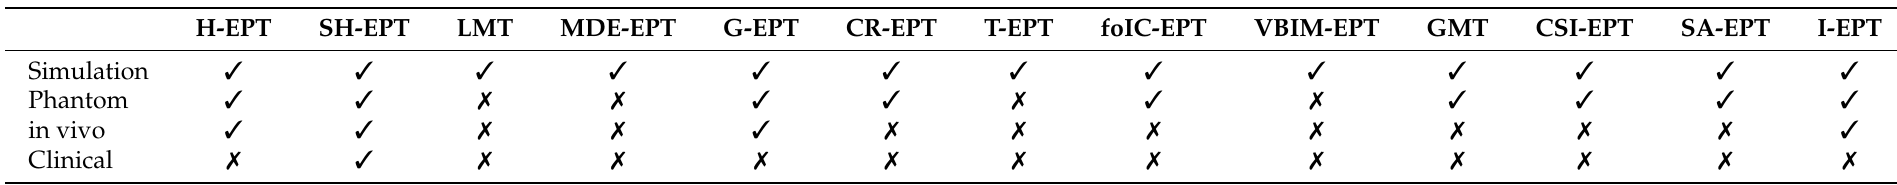
Table 3. Type of experiments performed for the EPT approaches as described in this manuscript. The table is constructed to the best of the authors knowledge. For references, see the main